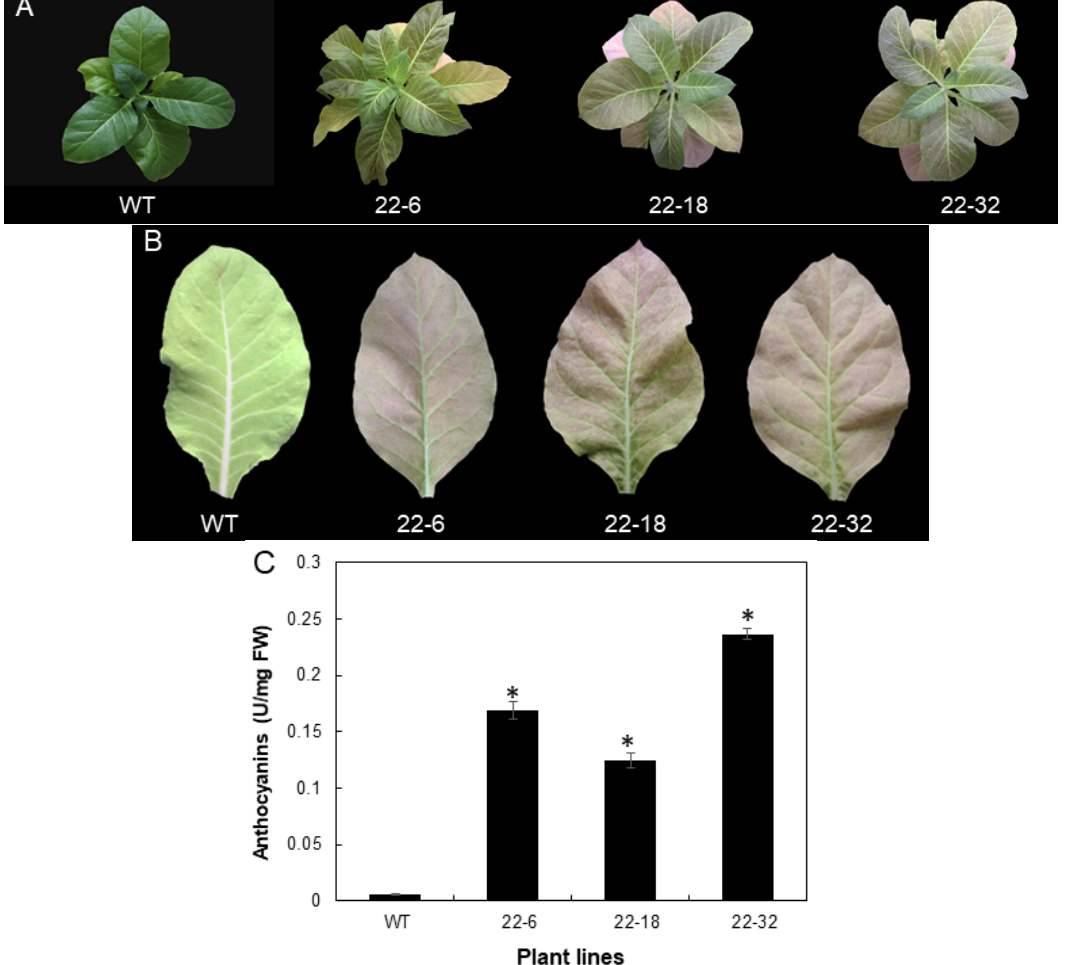
Figure 5. Promoted anthocyanin biosynthesis in transgenic tobacco T2 plants. ( A ) phenotype of WT and three T2 plants of transgenic line #22. ( B ) phenotype of representative leaves detached from WT and three T2 plants of transgenic line #22. ( C ) relative content of anthocyanins in leaves of WT and three T2 plants of transgenic line #22. Values in C are means ± SD ( n = 3). Asterisks indicate significant difference between various transgenic leaves and WT at p < 0.05, using the Student’s t -test.